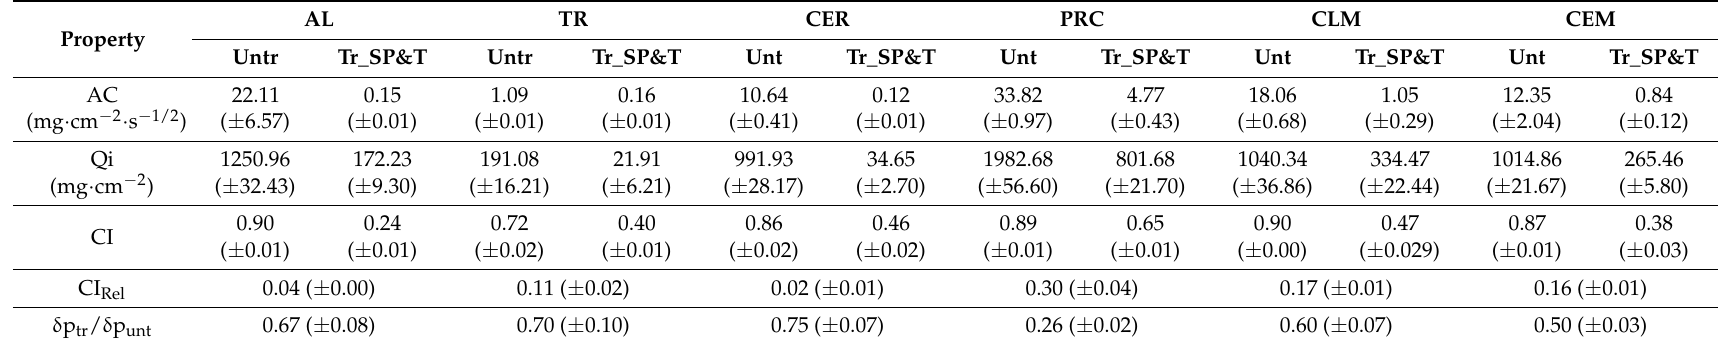
Table 6. Capillary Water Absorption Coefficient (AC, mg · cm − 2 · s − 1/2 ), Maximum Water Absorbed per unit area (Qi, mg · cm − 2 ), Absolute Capillary Index (CI)